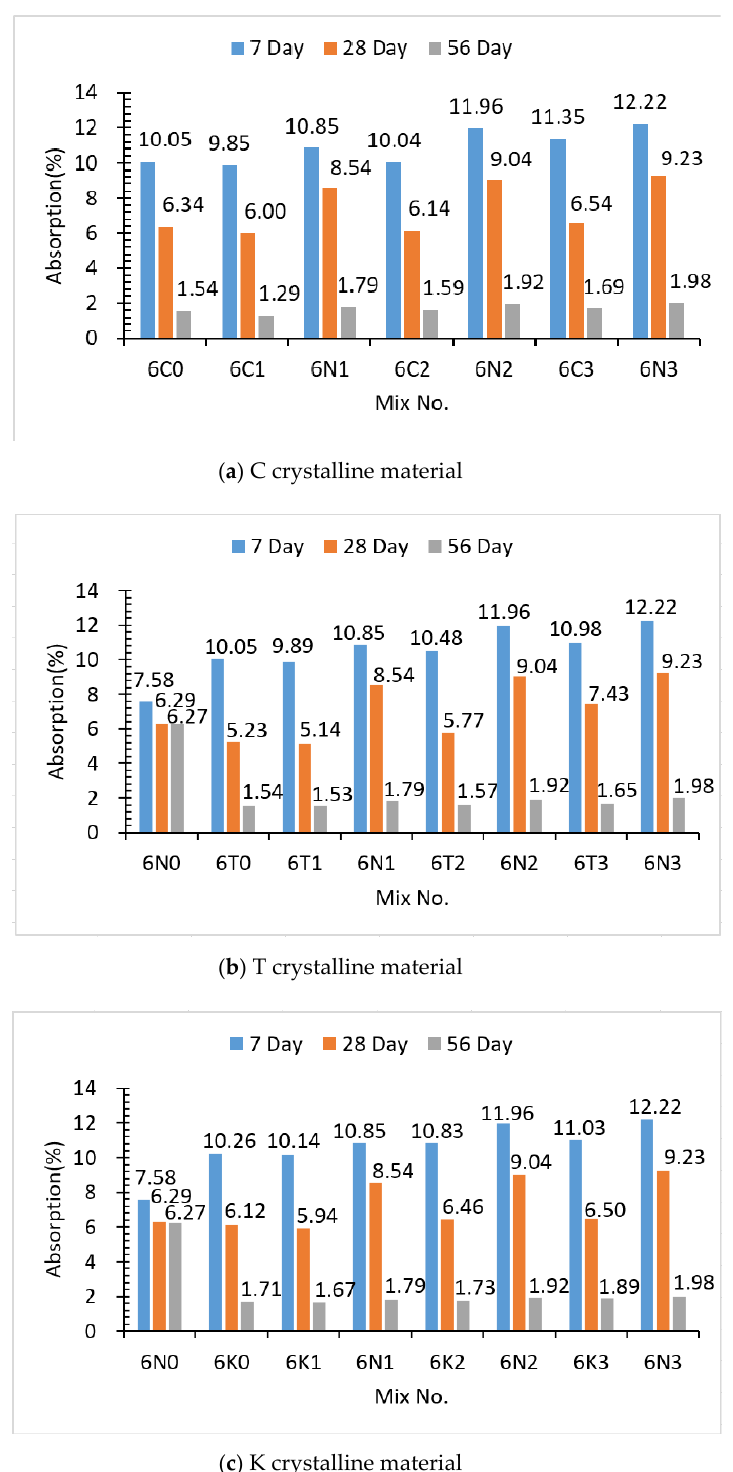
Figure 5. Saturated water absorption of cement mortar when W/C = 0.6.